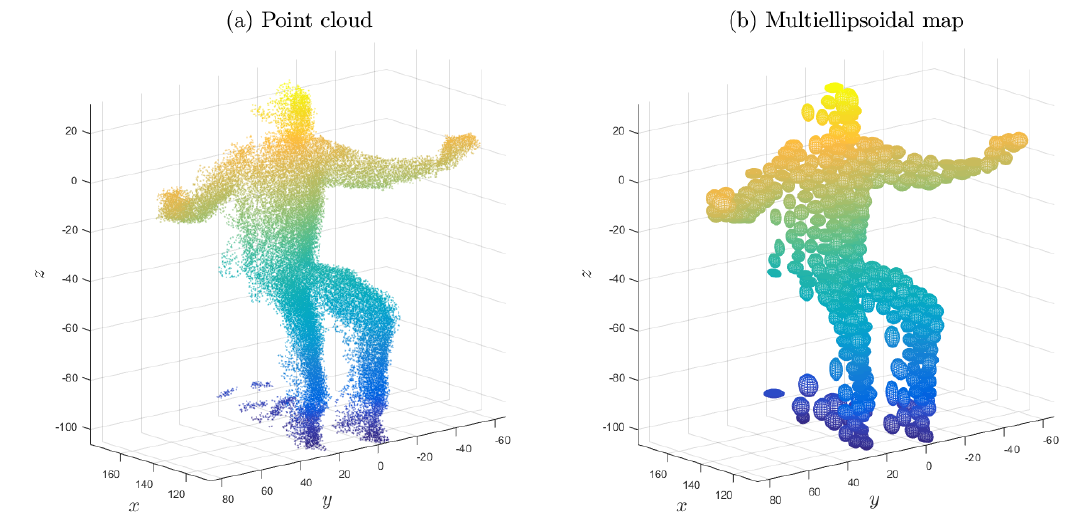
Figure 7. Experiment